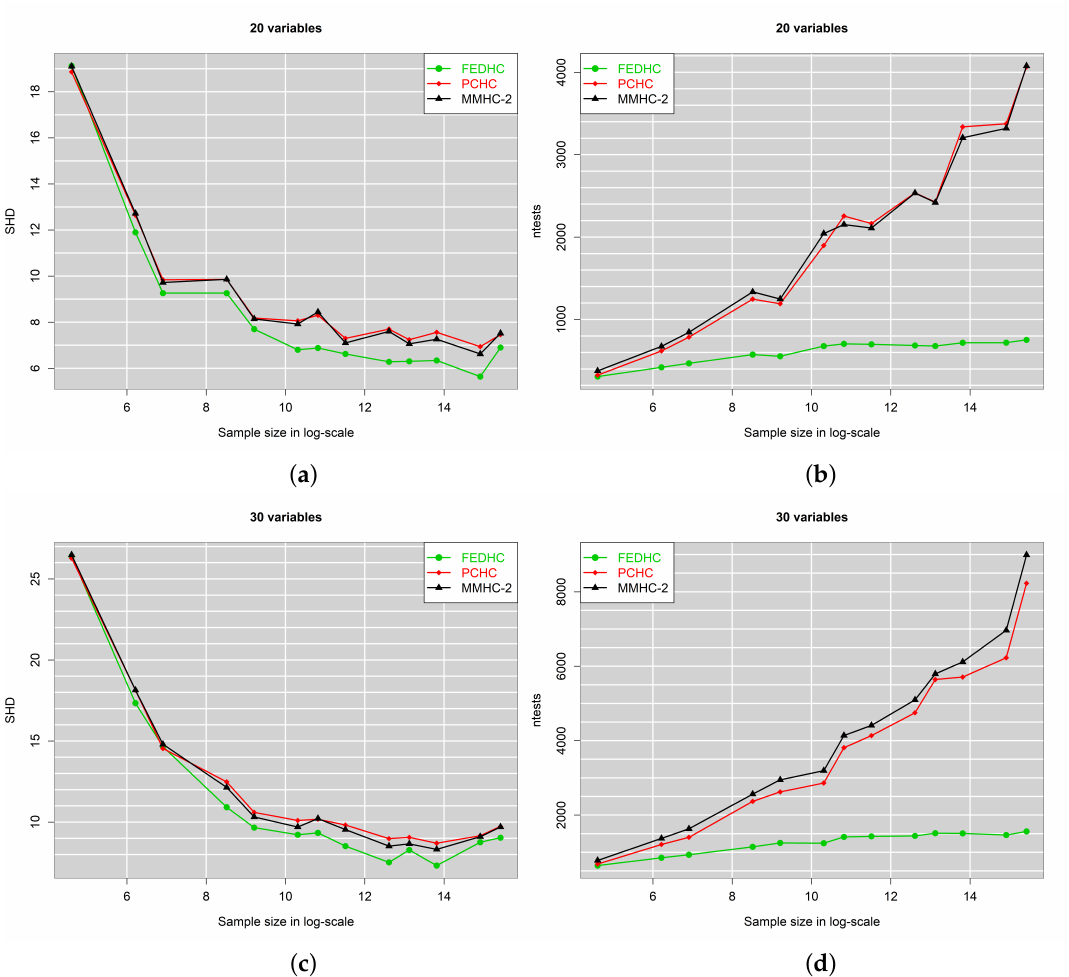
Figure 2. SHD and number of CI tests against log of sample size for 20 and 30 dimensions, with 3neighbours on average. ( a ) SHD vs. log of sample size. ( b ) Number of CI tests vs. log of sample size. ( c ) SHD vs. log of sample size. ( d ) Number of CI tests vs. log of sample